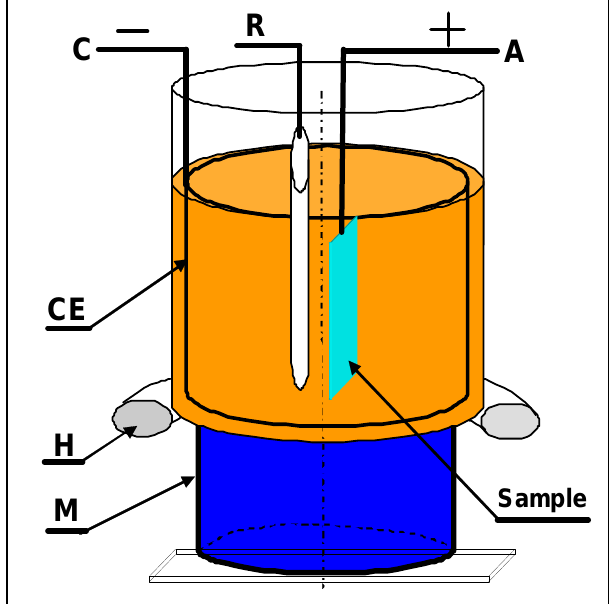
Figure 2. Magnetoelectropolishing MEP system used for investigation of polarization characteristics: A – anode, C – cathode, R – reference electrode, CE – counter electrode of cylindrical shape, CE – counter electrode, M – permanent magnet, H –